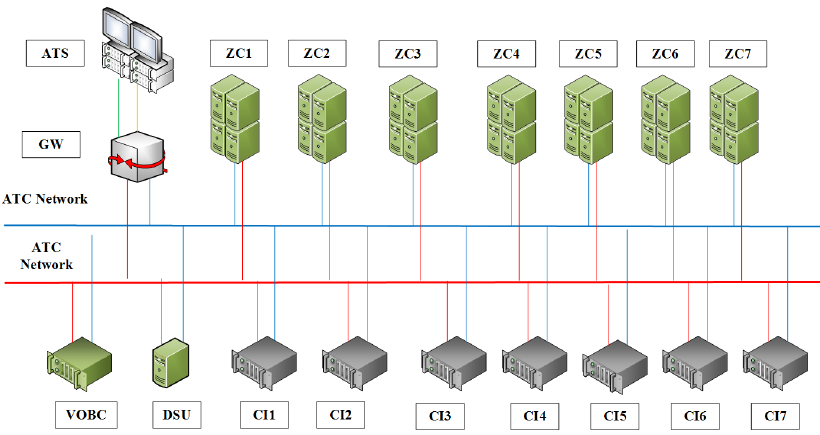
Figure 5. CBTC simulation platform.